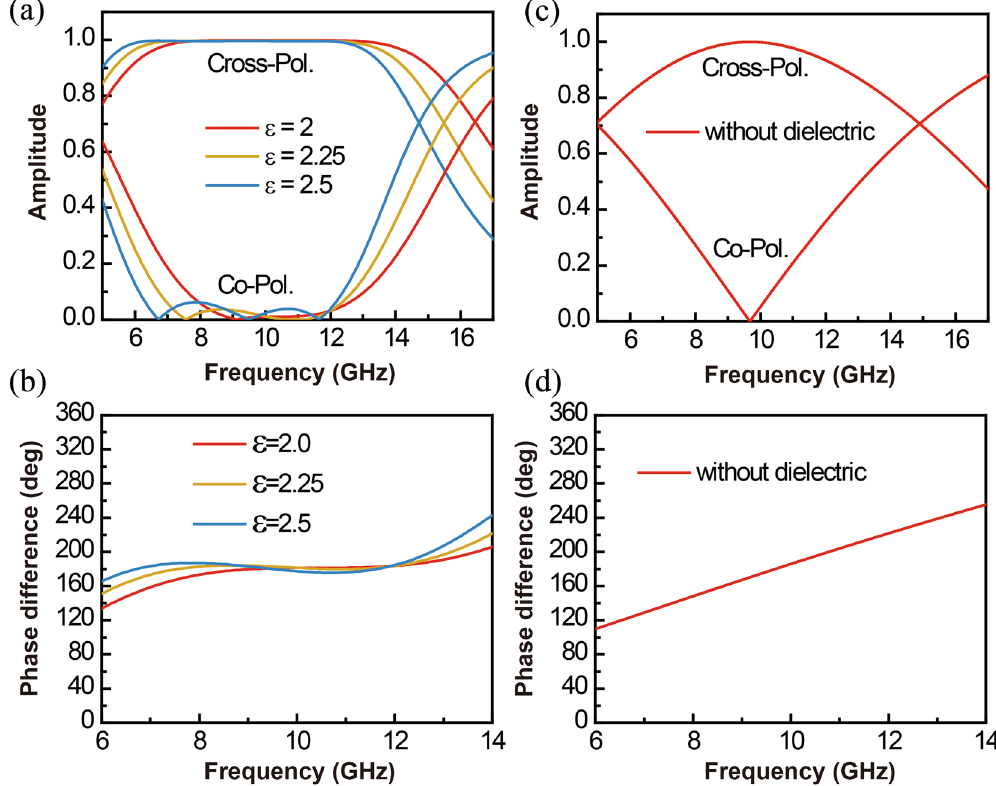
Figure 2. Numerical results for the proposed half-wave plate under normal incidence. ( a ) Amplitude coefficients for the co-polarized and cross-polarized components of the reflected beam. ( b ) Phase difference of the reflected beams between cases where the polarizations of the input beam are parallel and perpendicular to the grating wires. For comparison purpose, ( c ) and ( d ) sketch the response curves obtained for the narrowband design case where the dielectric slabs is